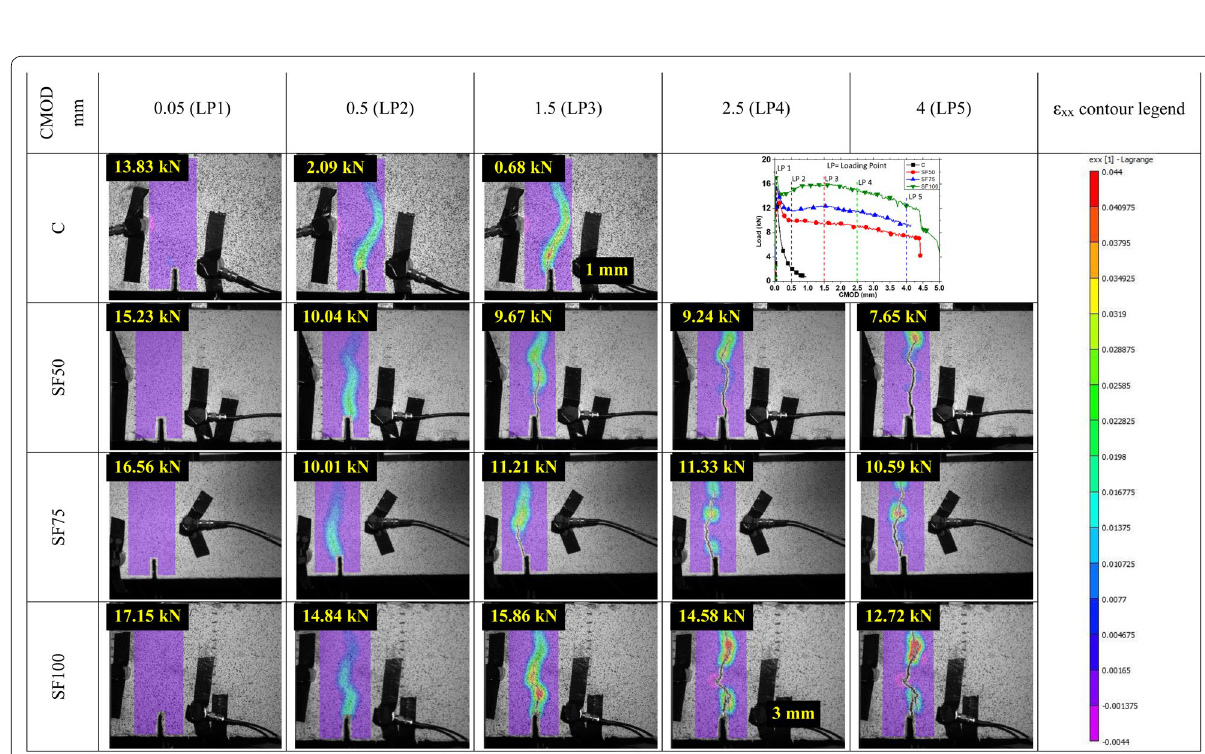
Fig. 11 Comparison of strains of SFRC with different fibre dosages at considered